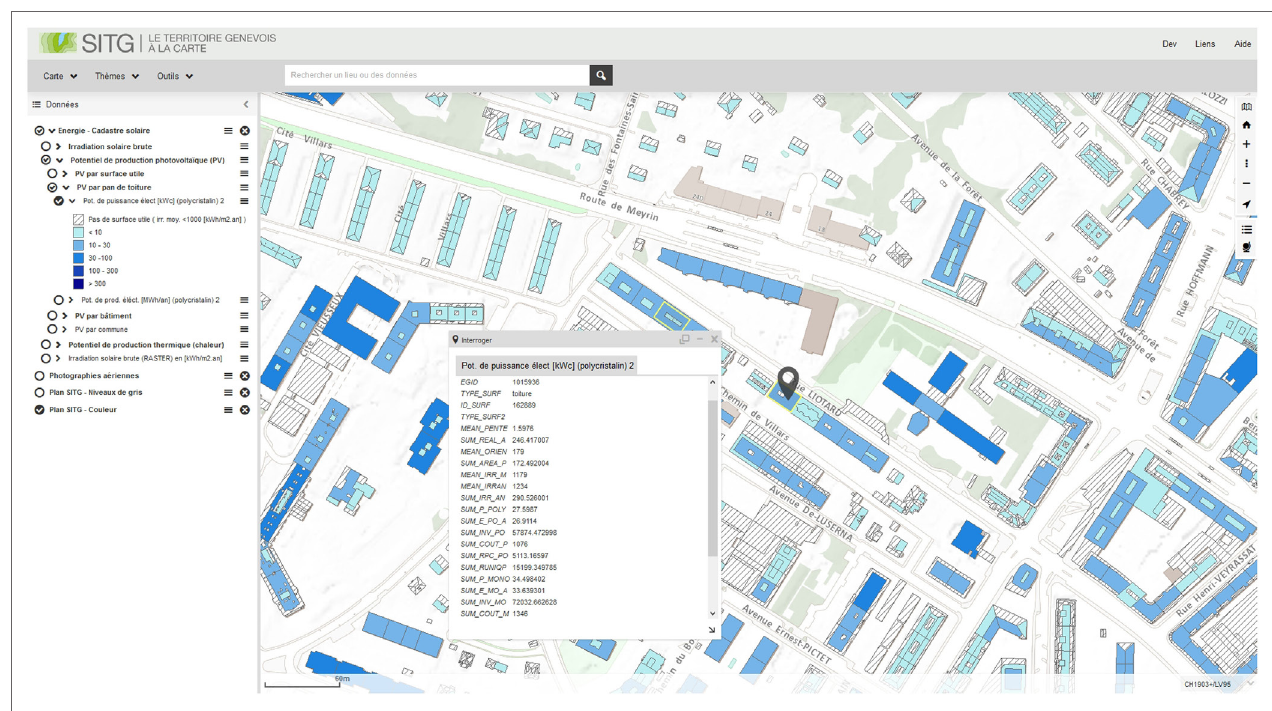
FIGURe 7 | Geneva Geoportal and specific section dedicated to solar cadaster layers. Reproduced from SITG—https://www.etat.ge.ch/geoportail/ pro/?mapresources = ENERGIE_SOLAIRE (2017). No permission is required from the copyright holder for the use of this image in this